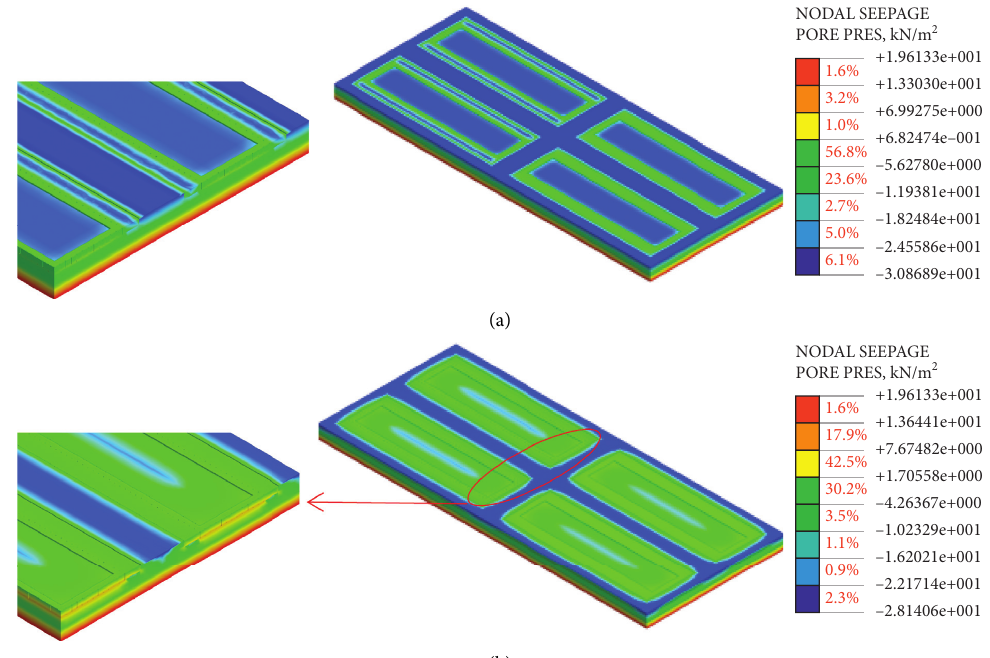
Figure 27: Pore water pressure nephograms of buildings with seepage wells placed around buildings 1 and 2 after (a) 10min and (b) 120min of rainfall in the numerical model (the color of the legend represents the pore water pressure range. The value of the legend represents the pore water pressure value. The red % represents the volume percentage of color legend in the whole numerical